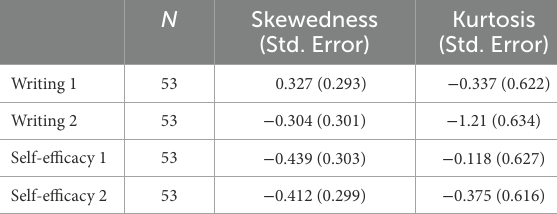
TABLE 1 Testing the normality of the